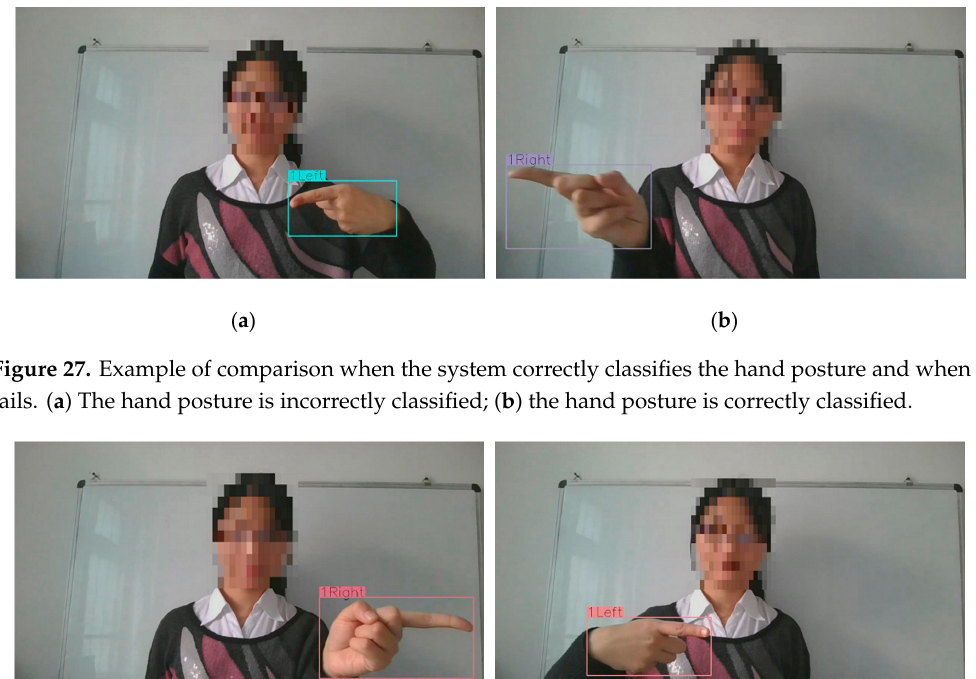
Figure 28. Example of comparison when the system correctly classifies the hand posture and when it